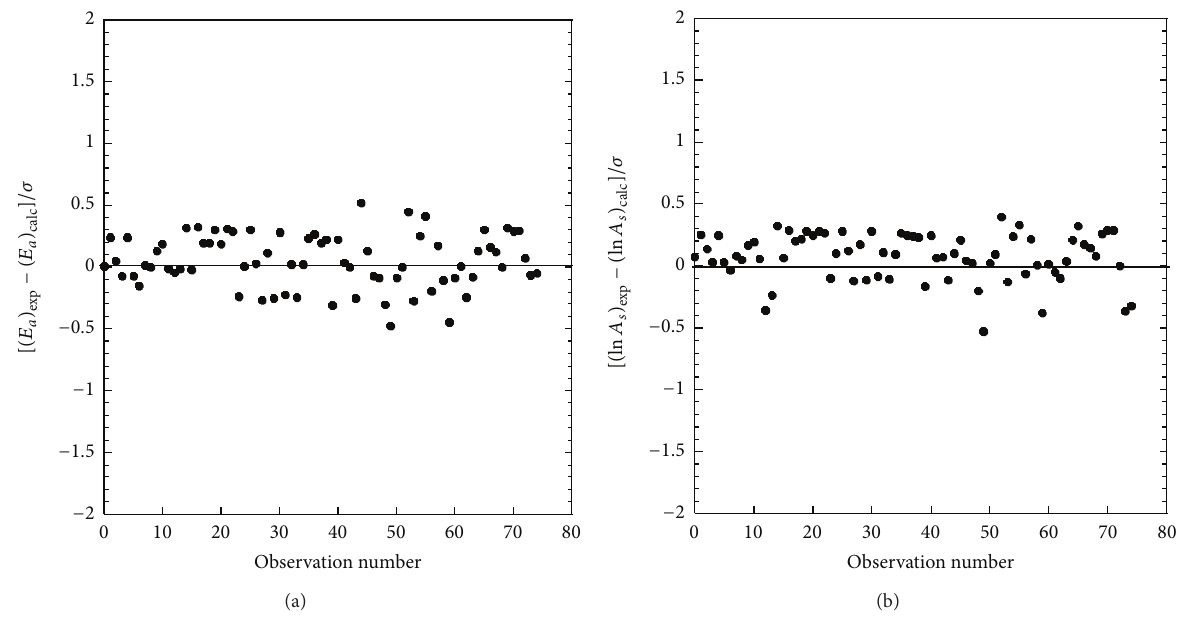
]/𝜎 and (b) the entropic factor [( ln 𝐴 calc